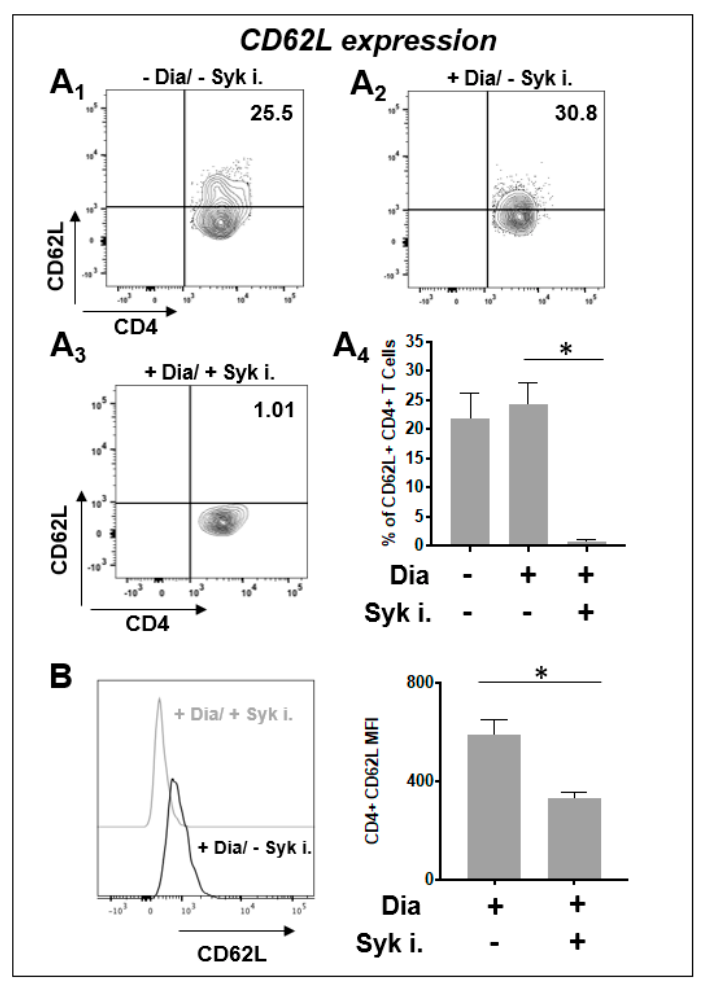
Figure 7. Expression of T cells CD62L receptor after treatment with diamide and Syk inhibitors. Cells exposed to 0.3 mM diamide with / out 5 µ M Syk inhibitors (Syk i) at 60 minutes incubation time. Samples were incubated surface-CD62L and analyzed by Flow cytometry (N = 3). ( A1 ) Anti-human CD62L flow representative density plot of untreated cells. ( A2 ) Anti-human CD62L flow representative density plot of T cells exposed to 0.3 mM diamide. ( A3 ) Anti-human CD62L flow representative density plot of T cells exposed to 0.3 mM diamide and incubated with Syk inhibitor. Medians are showed. p values which were statistically significant are shown (* p < 0.05). Values are plotted as mean ± error standard ( A4 ). Data are the percentage of total cell population (%). ( B ) Samples were incubated with human surface anti-CD62L and analyzed by Flow cytometry. Comparison of MFIs between diamide-treated T cell samples in presence versus absence of Syk inhibitors incubation.